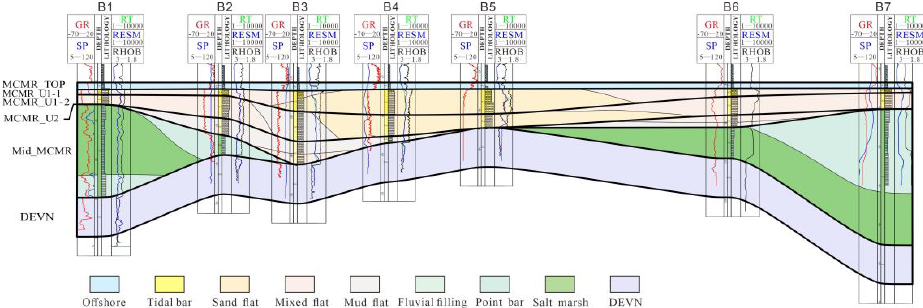
Figure 6. Architectural elements analysis of cross-section 2. (The section location is shown in Figure 4).